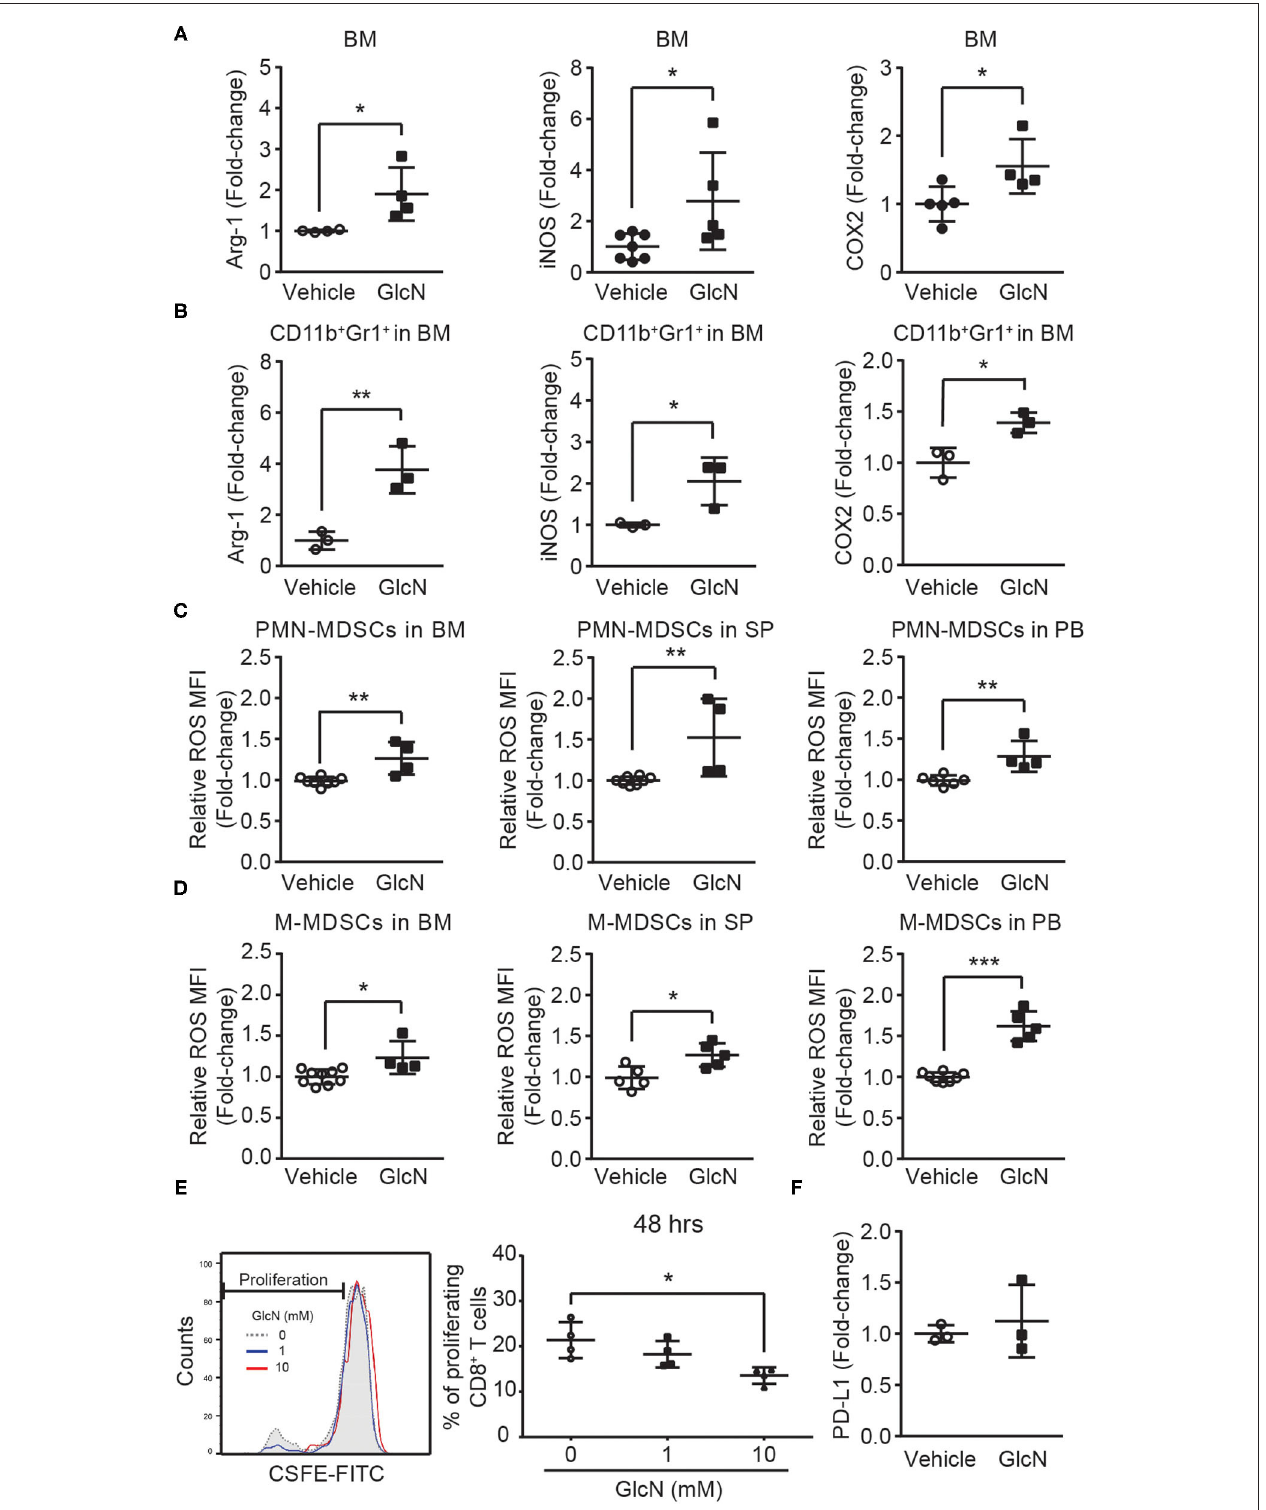
FIGURE 7 | GlcN treatment enhances the immunosuppressive ability of MDSCs. Mice were treated with GlcN by i.p. injection for 14 days. Arg-1, iNOS, and COX2 expression levels in (A) total BM cells and (B) BM CD11b + Gr1 + MDSCs. ROS levels in (C) PMN-MDSCs and (D) M-MDSCs isolated from BM, SP, and PB. (E) T cell immunosuppressive ability of BM CD11b + Gr1 + MDSCs. (F) Quantification of PD-L1 expression levels in BM cells. MFI: Mean fluorescence intensity. Quantified results are presented as the mean ± standard deviation. * P < 0.05; ** P < 0.01; *** P < 0.001.